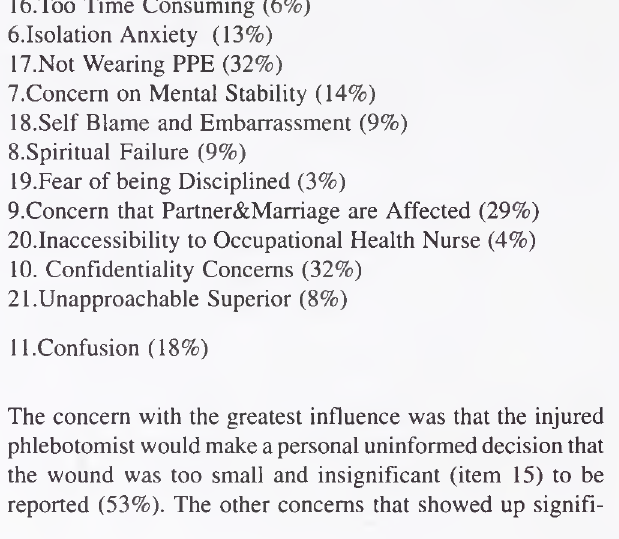
Figure 1: Concerns of the